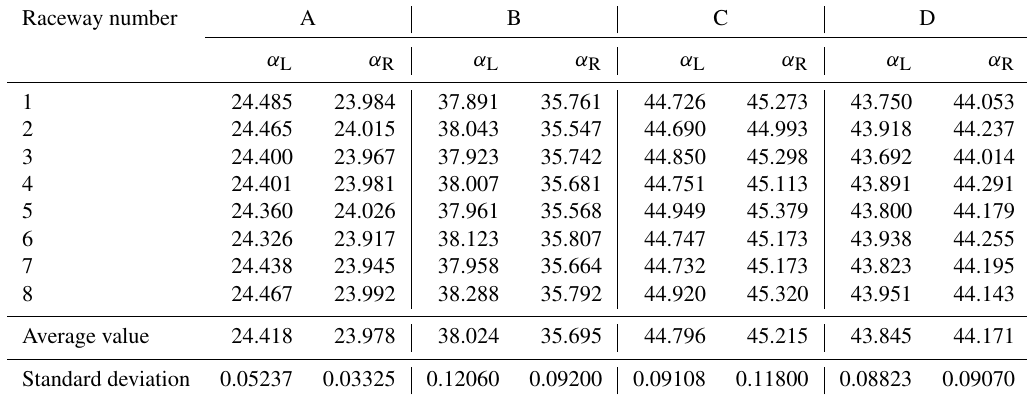
Table 3. Contact angle ( ◦ ).